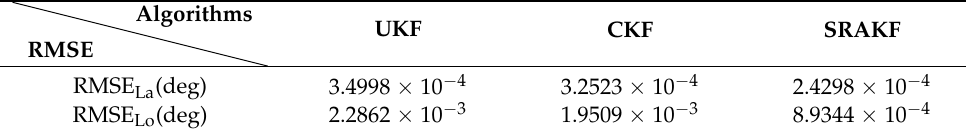
Figure 10. Longitude errors for the surface lake trials. Table 3. RMSE for different algorithms.